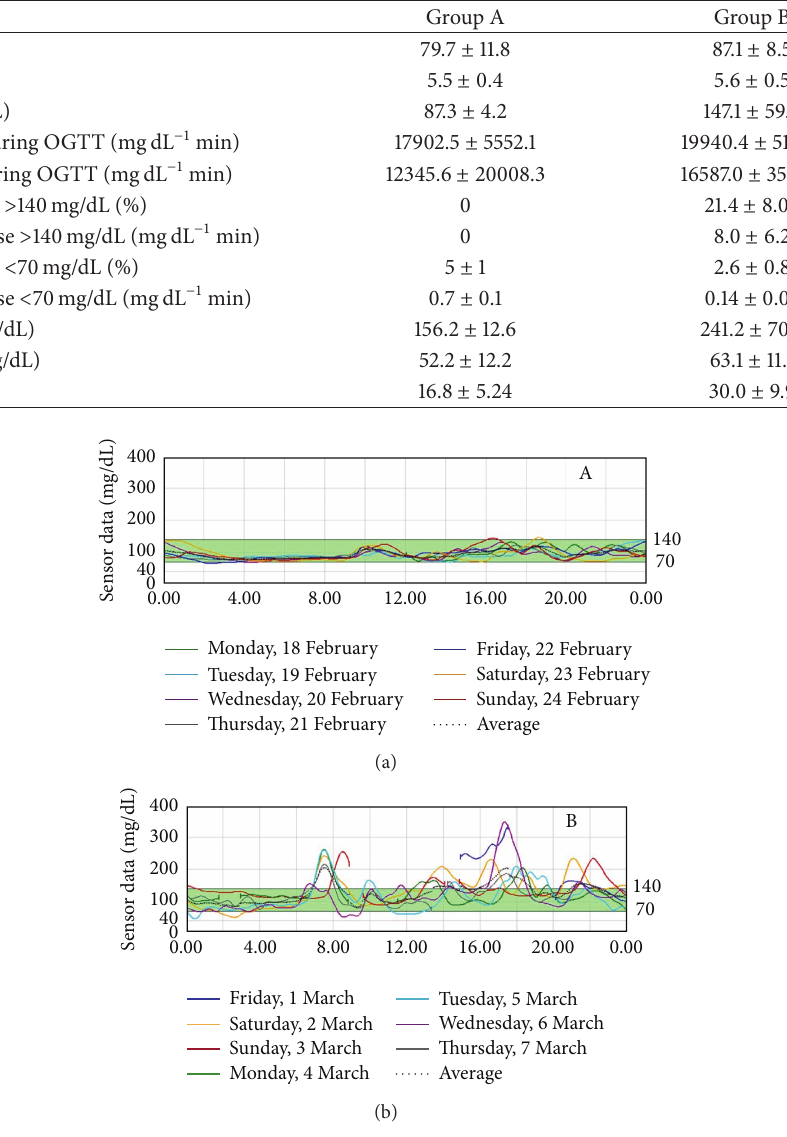
Figure 1: CGM profile in one patient of group A and in one patient of group